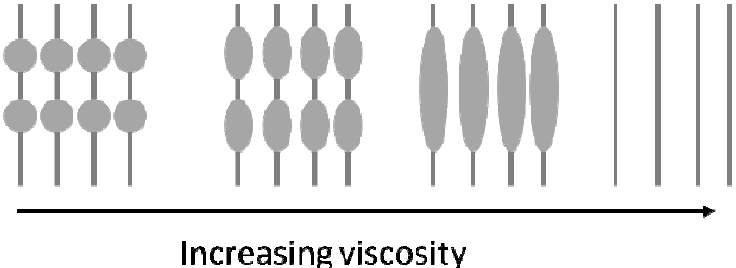
Figure 2. Schematic showing the effect of increasing the polymer solution viscosity on the morphology of the resulting electrospun